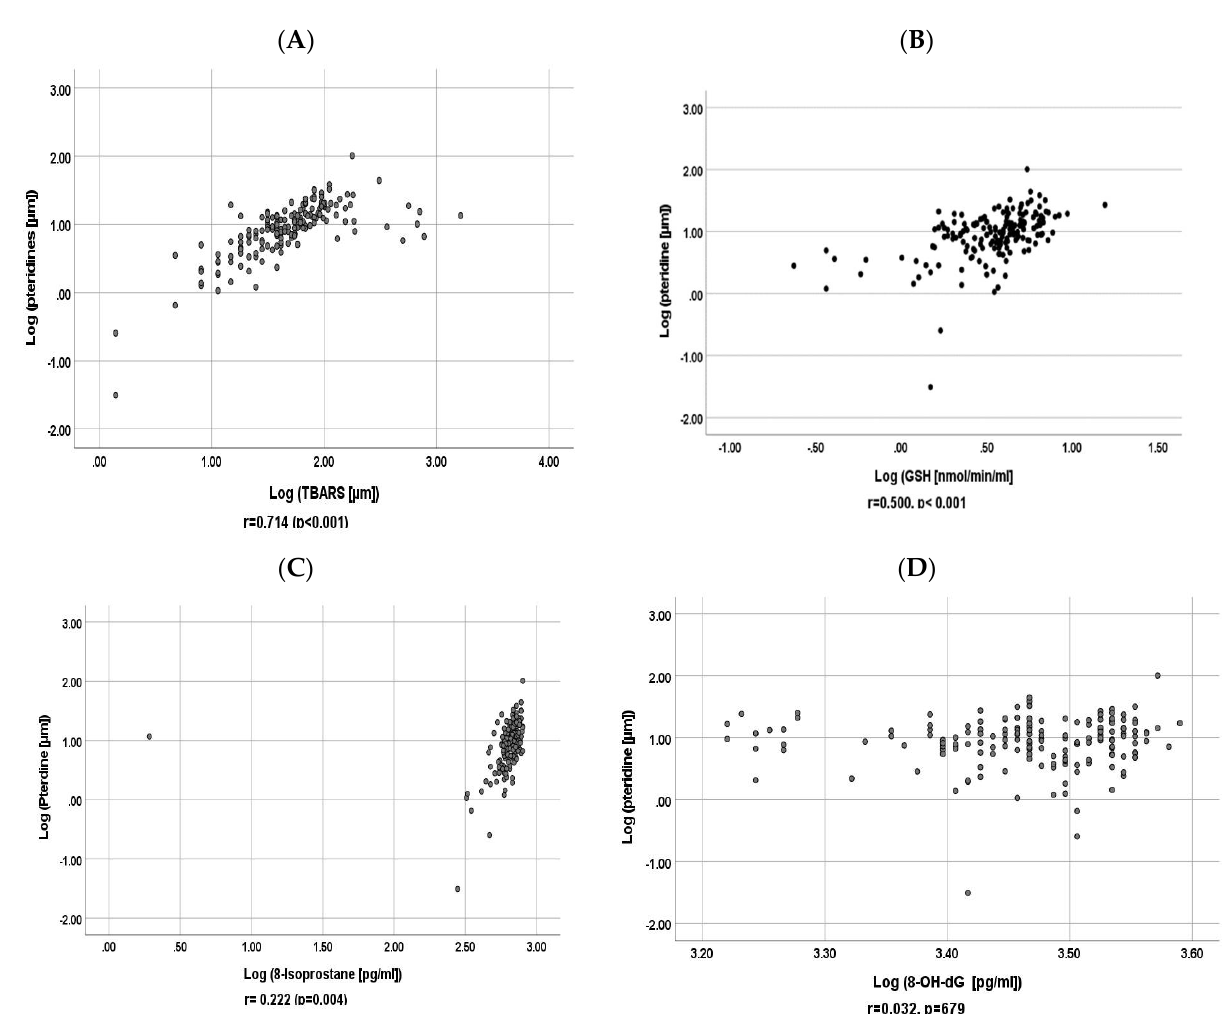
Figure 2. Scatter plots for correlations of log-transformed baseline urinary pteridine with log trans- formed baseline ( A ) urinary TBARS, ( B ) GSH, ( C ) 8-isoprostane, and ( D ) 8-OH-dG.